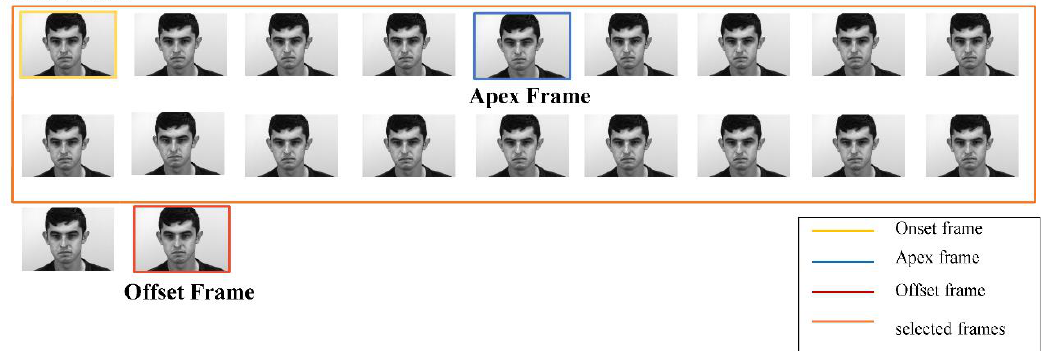
Figure 3. Frame selection with 9 frames before the apex frame and 8 frames after the apex frame.